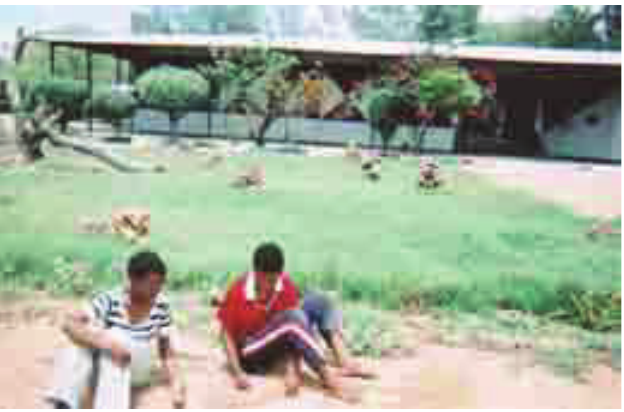
Figure 3: Two girls playing Morabaraba game